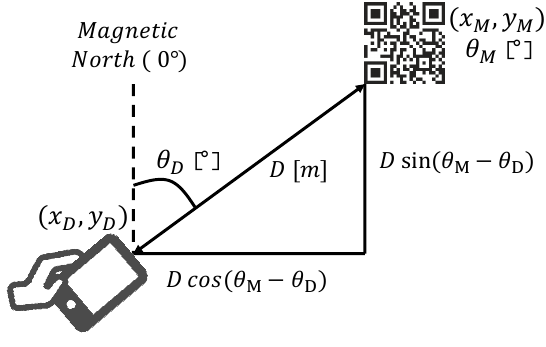
Figure 7. Estimation of current smartphone position using QR